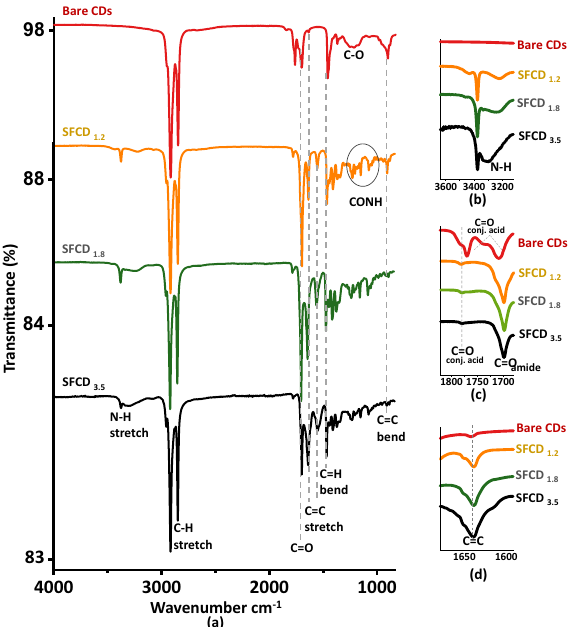
Figure 6. ( a ) FTIR spectra of bare CDs and SFCDs. Bare CDs FTIR spectra show C=O stretching vibrations of conjugated acid at 1779 cm −1 , 1768 cm −1 and 1708 cm −1 , C=C stretching vibration at 1638 cm −1 , and a broad band of C−O stretching vibrations at 1218 cm −1 . SFCDs show signature peak of N−H stretching vibrations at ~ 3436−3218 cm −1 , C=O stretching vibration of primary amide at 1698 cm −1 and a band of CONH stretching vibrations at 1233 cm −1 . Peaks at 2918, 2847 cm −1 correspond to C−H stretching vibrations and peaks at 1468 cm −1 , 908 cm −1 correspond to C−H bending and C=C bending modes respectively. Further figure shows enlarged image of ( b ) N−H stretch region, ( c ) C=O stretch region and ( d ) C=C stretch region. It is observed that with increase in surface functionalization (SFCD 1.2 to SFCD 3.5 ) an increase in the peak width and intensity of N−H stretching vibrations and an increase in the peak intensities of C=O, C=C stretching vibrations are